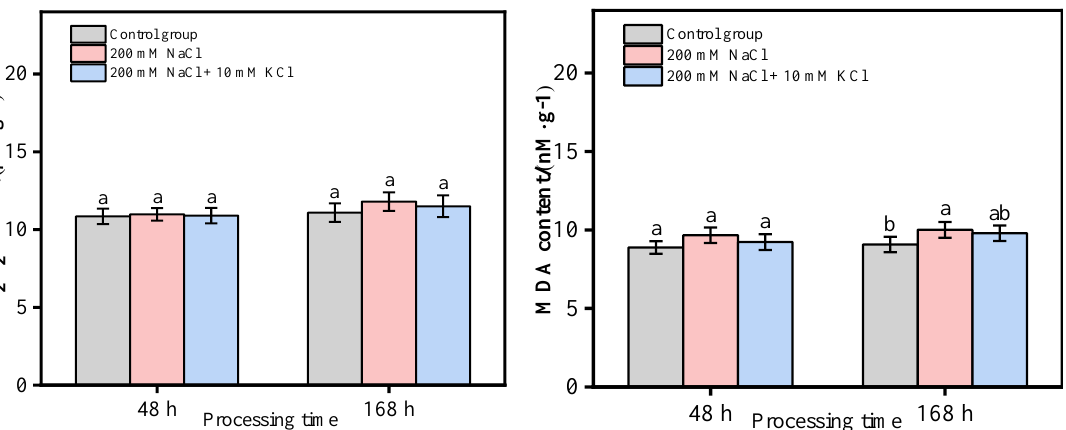
Figure 2. Changes of H 2 O 2 and MDA content in leaves of T. ramosissima under different treatments. Changes of H 2 O 2 and MDA content in the leaves of T. ramosissima at 48 h and 168 h in the control group and different treatment groups. Note: different letters indicate the significance of differences among treatments at the same time, p < 0.05.